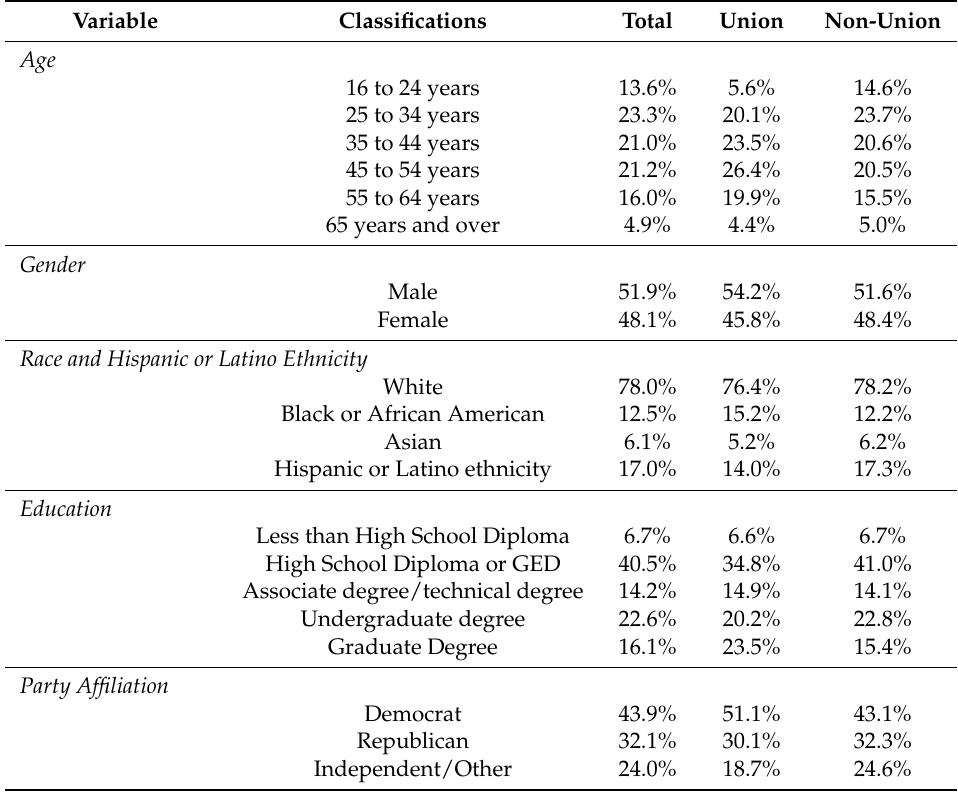
Table 2. Characteristics of